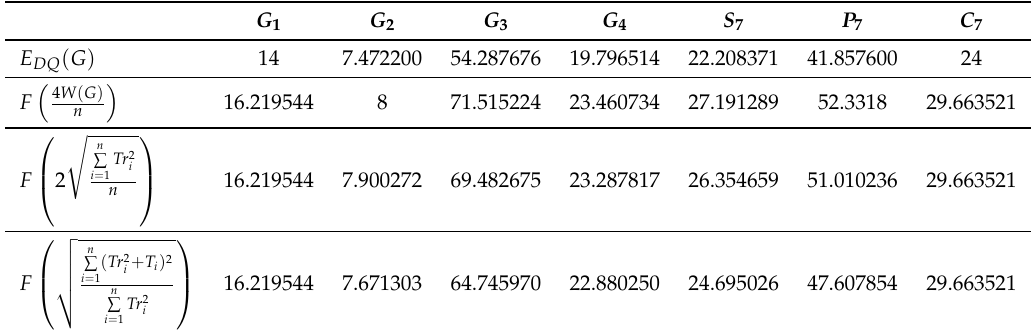
Table 2. Upper bounds for EDQ(Gi), using six decimal places, where Gi is given in Figure